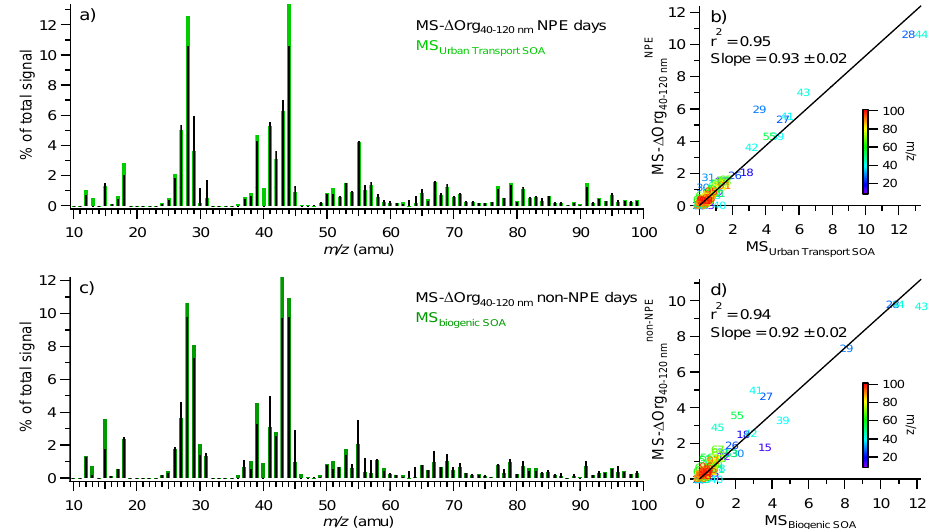
Figure 12. Average mass spectra of (a) urban transport SOA and 1 Org 40 − 120nm (i.e., organics that contribute to the growth of 40–120nm particles) during NPE days at T1, and (c) biogenic SOA and 1 Org 40 − 120nm during non-NPE days at T1. Scatterplots that compare the mass spectra of (b) urban transport SOA vs. 1 Org 40 − 120nm during NPE days, and (d) biogenic SOA vs. 1 Org 40 − 120nm during non-NPE days. The data fitting of these two scatterplots was performed using the orthogonal distance regression